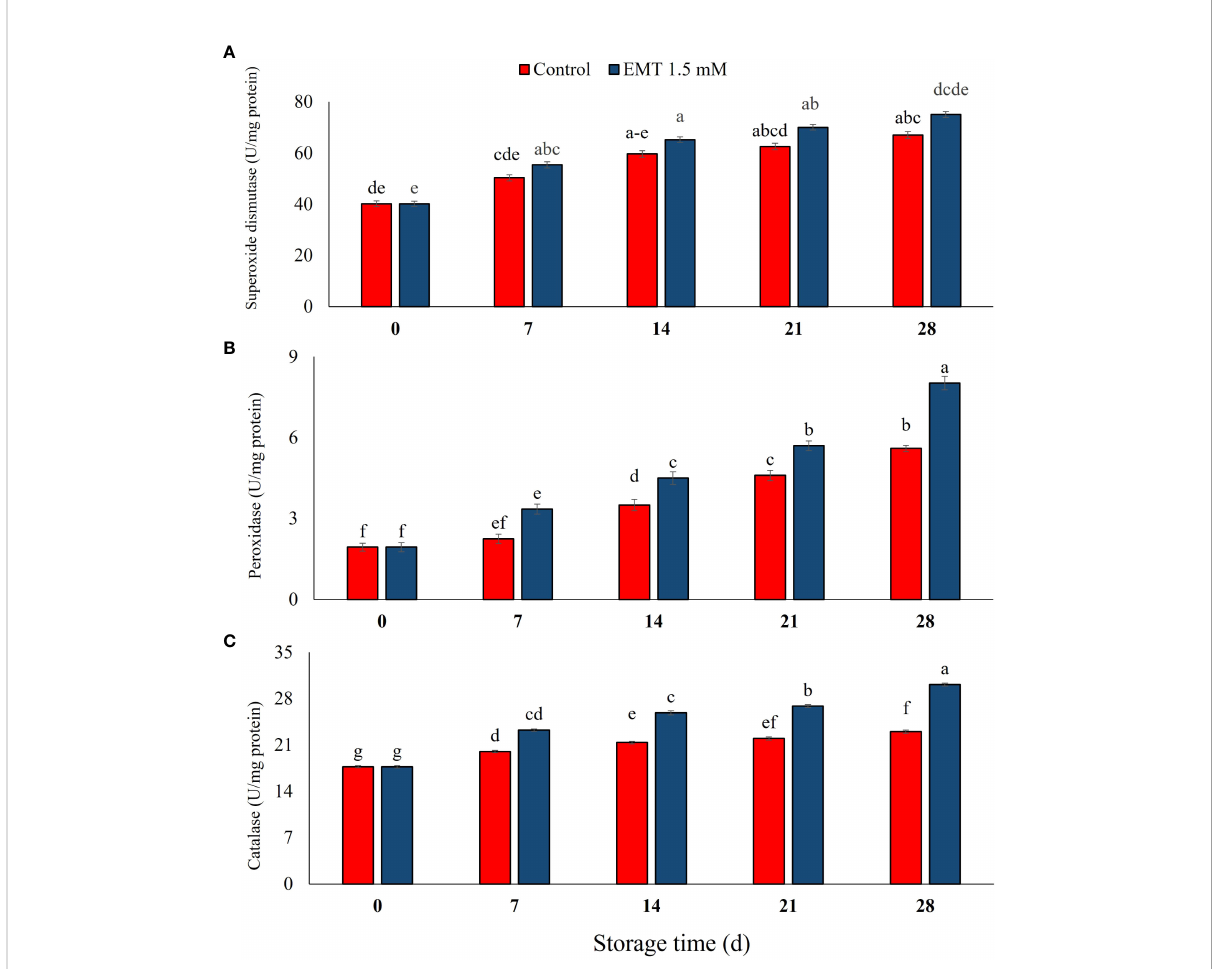
FIGURE 6 Effect of EMT treatment on superoxide dismutase (U mg − 1 protein) (A) , peroxidase (U mg − 1 protein) (B) , and catalase (U mg − 1 protein) (C) of papaya fruits during cold storage. Data collected from the mean of three replicates, and vertical bars indicate the standard error of the means. Mean values with different letters show signi fi cant differences, and those with the same letters show no statistical difference according to the least signi fi cant difference test ( P <